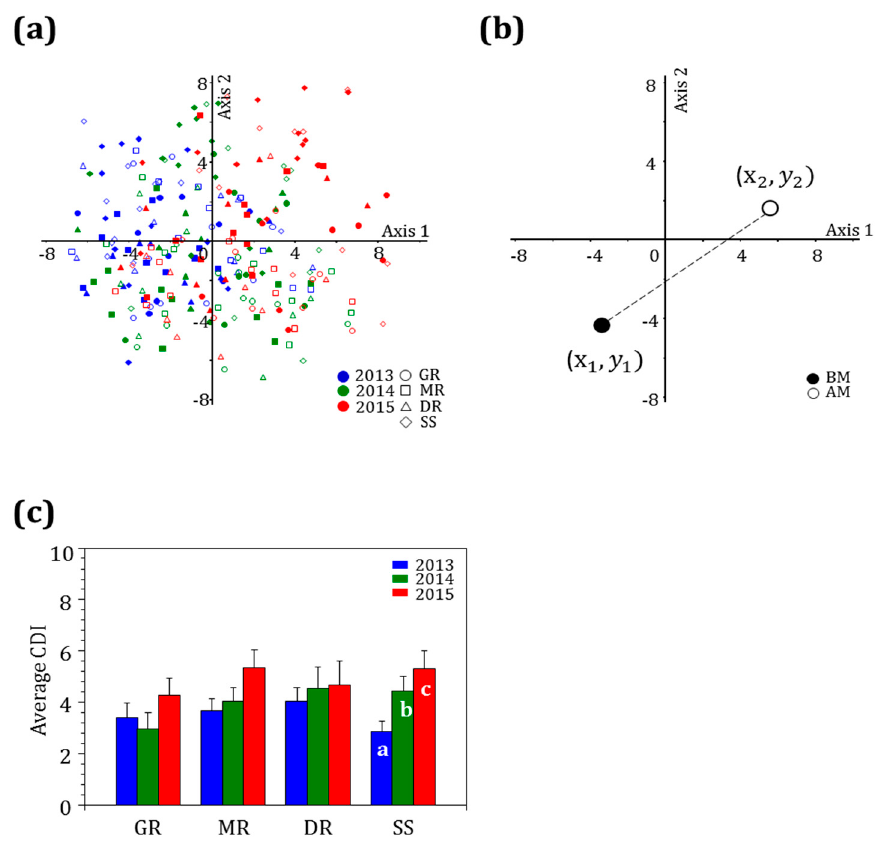
Figure 8. Epilithic diatom community characteristics before and after the monsoon in four central western major streams (2013–2015). ( a ) Principal component analysis (PCA) ordination, ( b ) Community dynamic index (CDI) calculation, ( c ) an average of the dynamic community index of epilithic diatom (GR: Geumgang River, MR: Mangyeonggang River, DR: Dongjingang River, SS: Sapgyocheon stream). Superscripts a, b, and c are Tukey’s post hoc test after the Bonferroni test.